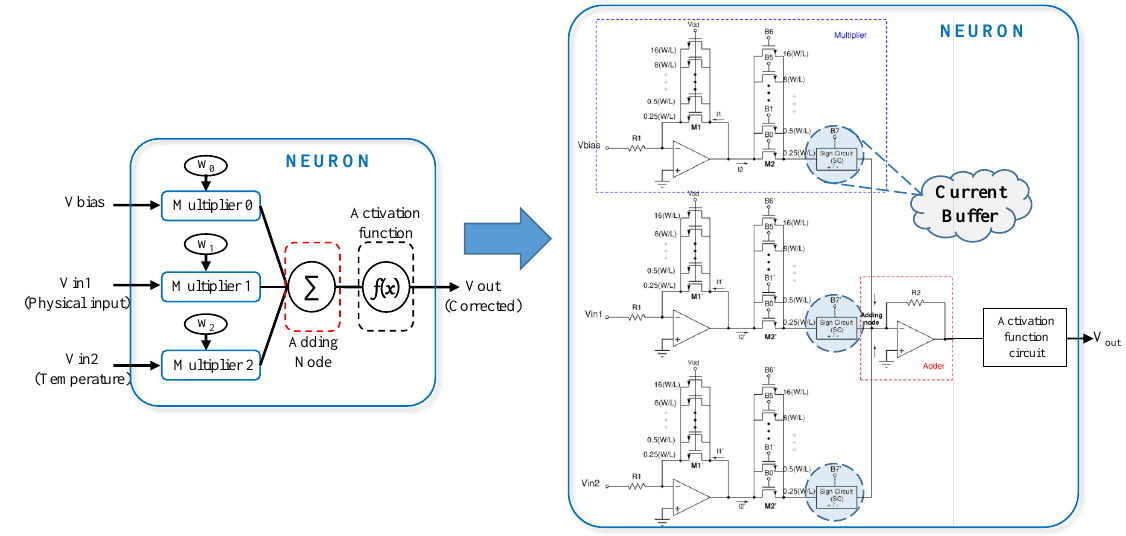
Figure 1. Neuron configuration implemented within the neural network-based microelectronic circuit for sensor